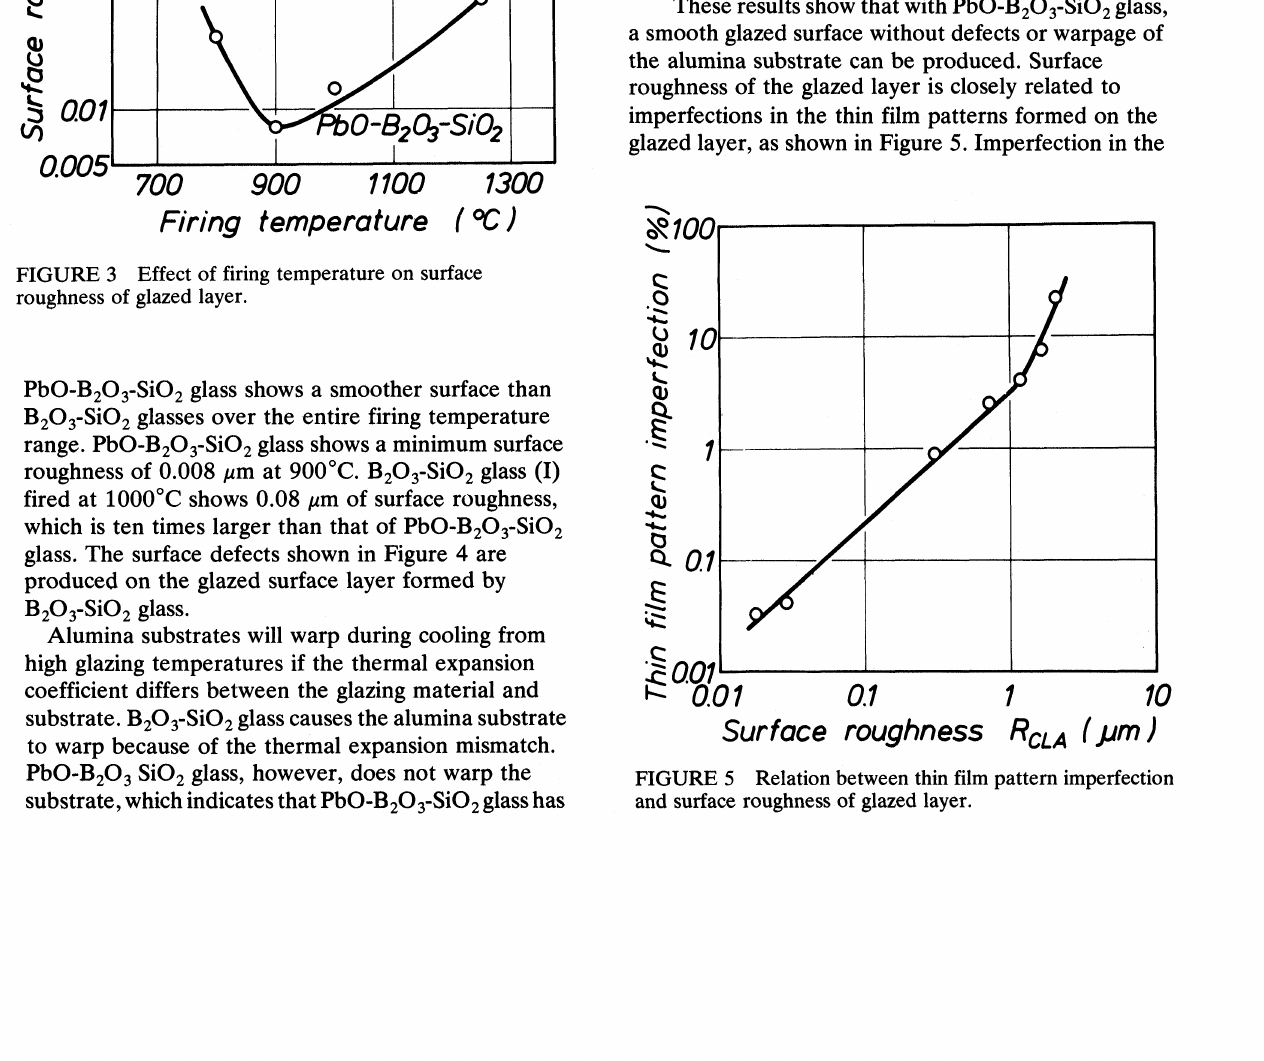
FIGURE 4 Surface defects formed on B203-SiO layer.